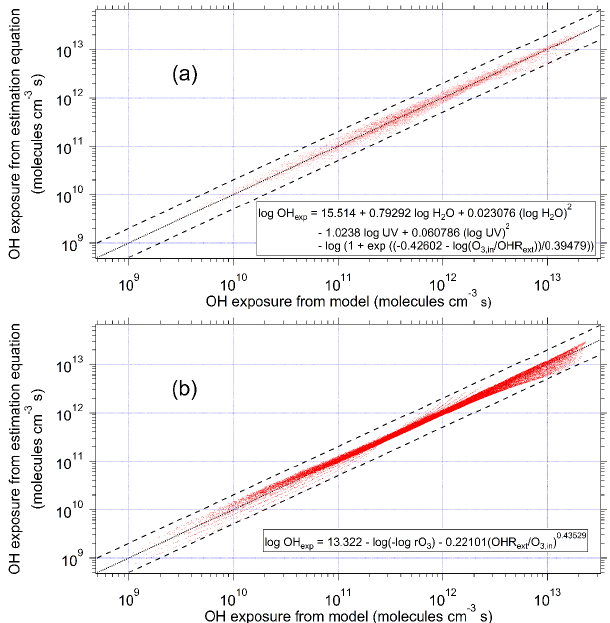
Figure 12. Comparison of OH exposure (OH exp ) estimated from the estimation equations, i.e., (a) Eq. (11) and (b) Eq. (12), vs. the model results. 1 : 1, 1 : 2, and 2 : 1 lines are also shown to facilitate the